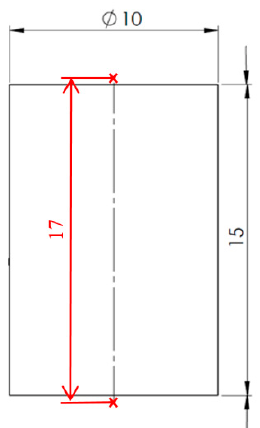
Figure 2. Drawing of tensile specimen.